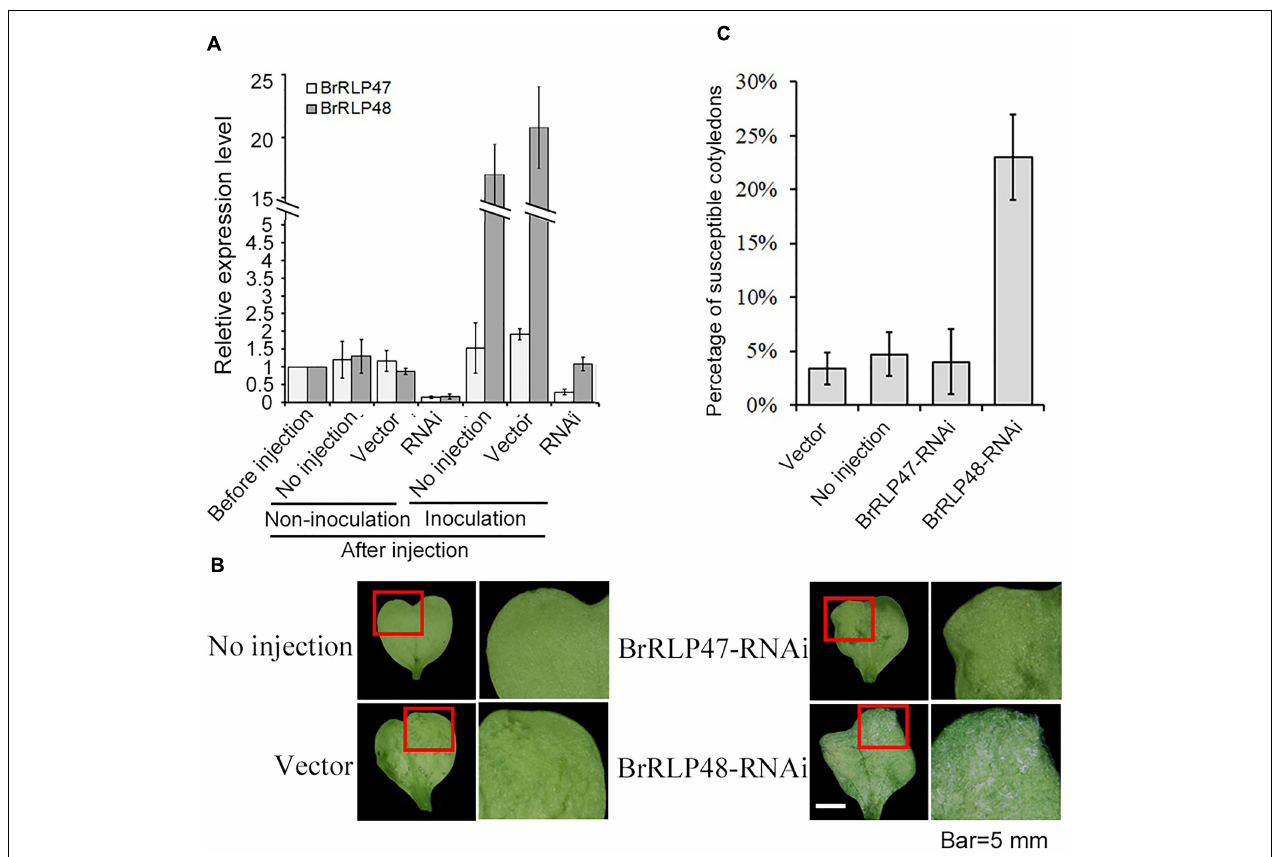
FIGURE 3 | Functional analysis of resistance candidate genes in their knock-down lines through agroinfiltration-mediated transient expression system. (A) Gene expression analysis in the cotyledons infiltrated with RNAi construct of BrRLP47 and BrRLP48 after injection. The cotyledons before injection, without injection (no injection), and infiltrated with Agrobacterium carrying empty vector pYBA1311 (vector) were conducted as controls. Three days after agroinfiltration without inoculation, the gene expressions were detected in “non-inoculation” group. The gene expressions in infiltrated cotyledons at 6 h after inoculation were tested in “Inoculation” group. Five to ten leaves were pooled in a single sample in each replicate. Expression of each gene in the cotyledons before injection was defined as 1.0. Values represent means ± SD ( n = 3) from three biological replicates. (B) The disease susceptible phenotypes of cotyledons injected with BrRLP47-RNAi , BrRLP48-RNAi , RNAi-empty vector (vector) , and cotyledons without injection were observed 3 days after agroinfiltration. The images in red squares are magnified in the pictures in the second column from the left. (C) The percentage of susceptible injected cotyledons after inoculation. Values represent means ± SD from three independent experiments. Each experiment tested at least 50